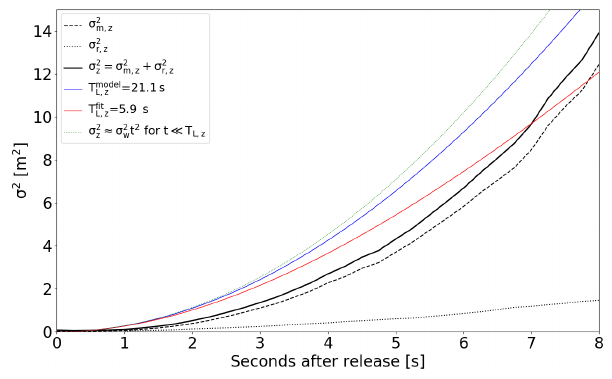
Figure 14. Absolute dispersion in the vertical (solid black line). Relative dispersion and meandering are shown with dotted and dashed black lines, respectively. Two parameterizations of Taylor’s theorem are plotted: modelled from the sonic anemometer data (blue) and fitted to the measured absolute dispersion (red). For dis- persion times much smaller than the Lagrangian timescale, the ab- solute dispersion can be approximated by a t 2 -dependency